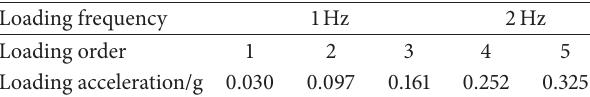
Table 4: Input acceleration of the model